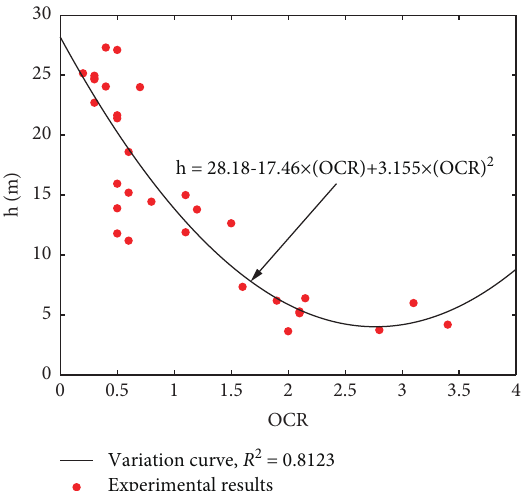
Figure 3: Variation curve of overconsolidation ratio with the depth in Jiangmen project silt layer.